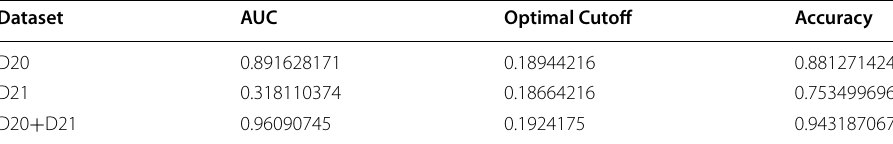
Table 1 XGBoost gives better results when combining two datasets appropriately